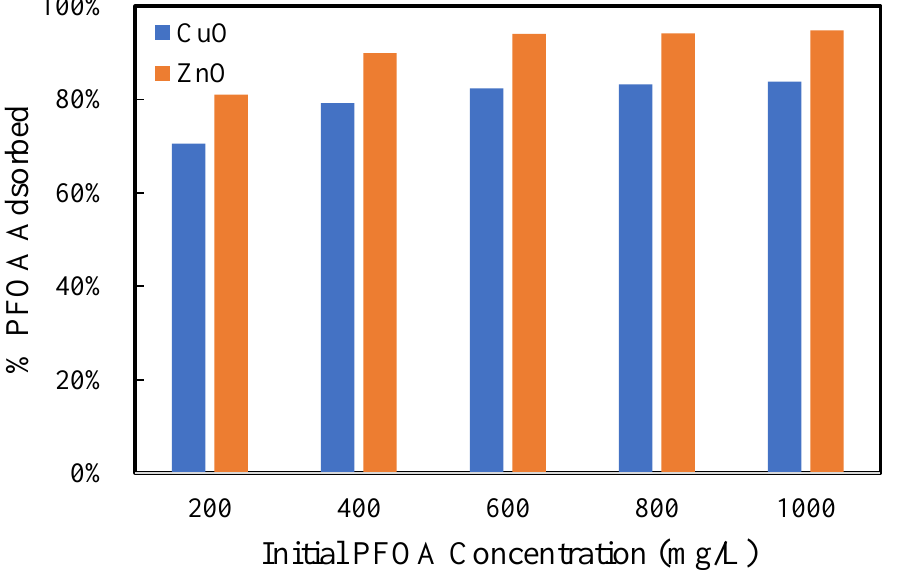
Figure 7. Percentage of PFOA removed from aqueous (DI water) solutions. 0.025 g particles and